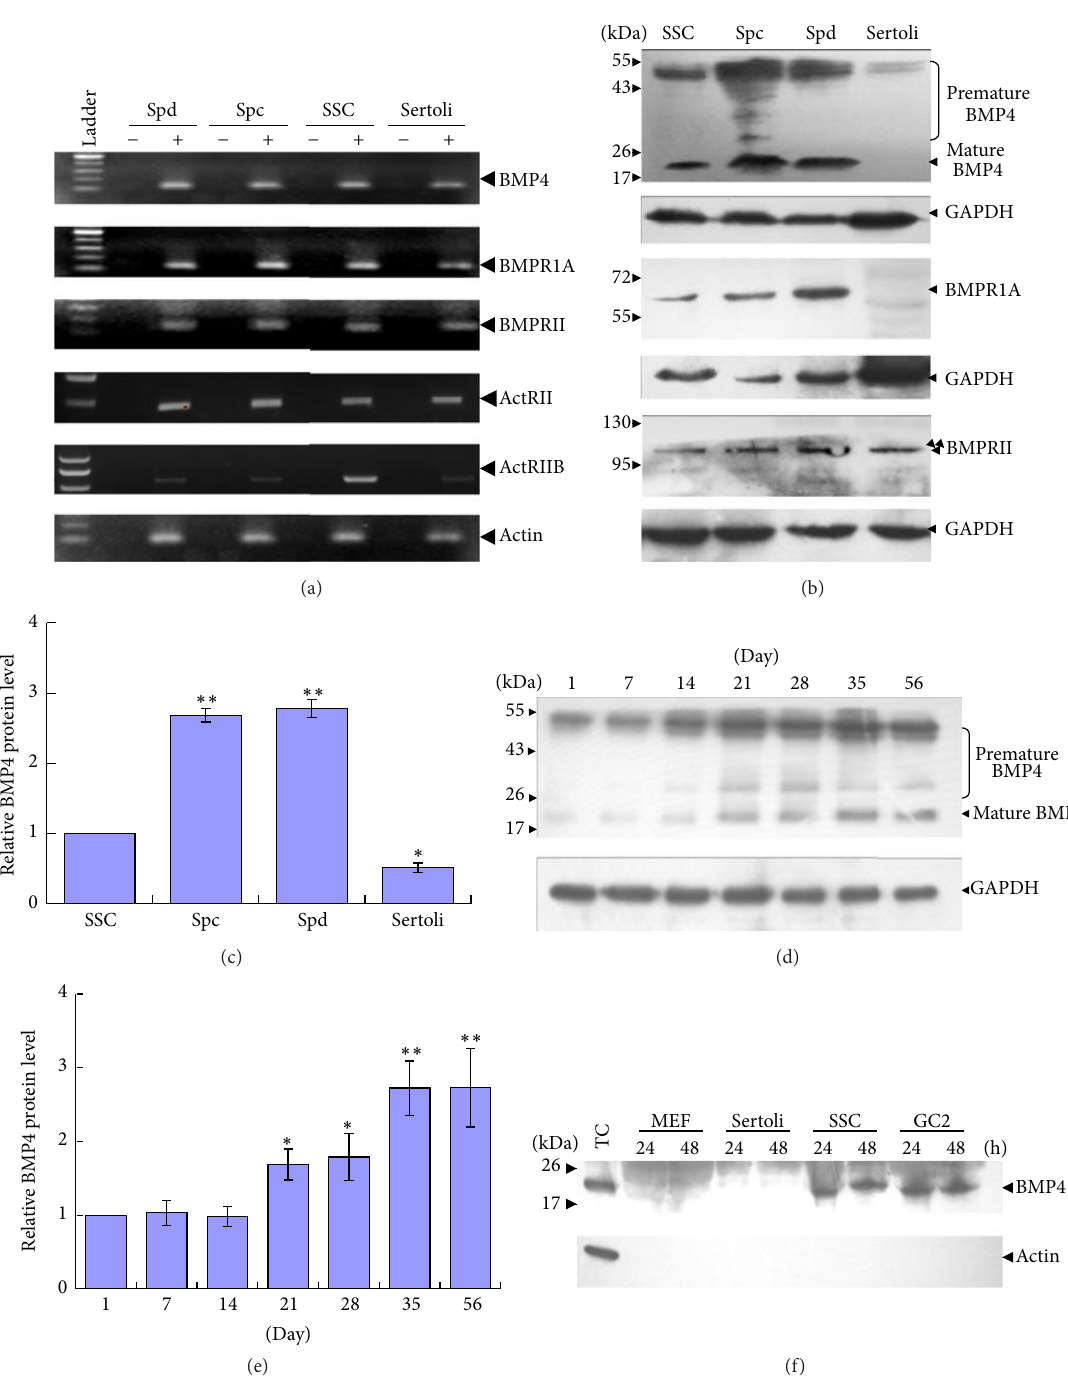
Figure 3: Expression of BMP4 and its receptor subunits in testicular cells. (a) RT-PCR analyses of the expression of BMP4 and its receptors BMPR1A , BMPRII , ActRII , ActRIIB, and actin in isolated spermatocytes (Spc) and round spermatids (Spd), as well as in cultured spermatogonia (Spg) and Sertoli cells (Sertoli). RNA samples without RT but with PCR amplification were used as negative control. (b-c) Western blotting analysis of the expression of BMP4 and its receptors in 4-5-day-old mouse Spg, adult Spc and Spd, and Sertoli cells (b) and quantification of BMP4 protein in these cells (c). The premature and mature forms of BMP4 were labelled. (d-e) Western blotting analysis of BMP4 protein in mouse testis at indicated development stages (d) and quantification (e). (f) Western blotting analyses of secreted BMP4 in the medium from different cell cultures. Adult mouse testicular cells lysate (TC) was used as positive control. The data is presented as means ± SD from at least three independent experiments. Statistically significant differences among groups are indicated by asterisks, ∗ 𝑃 < 0.05 or ∗∗ 𝑃 < 0.01